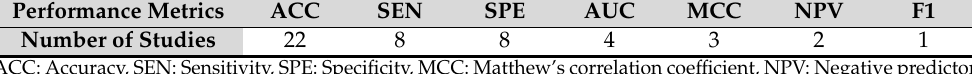
Table 1. Performance metrics of selected studies.